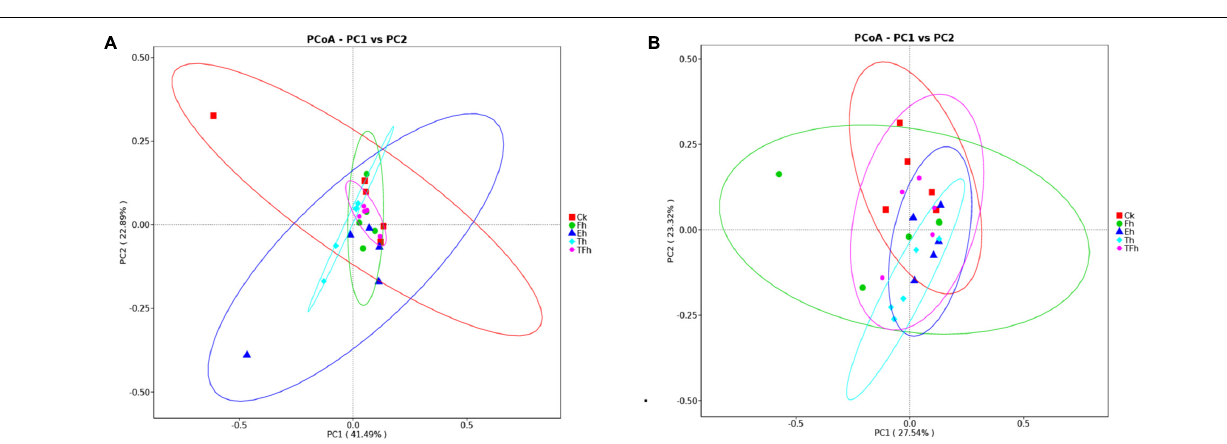
FIGURE 3 | Principal coordinate analysis (PCoA) of bacteria using distances based on weighted (A) and unweighted (B) UniFrac